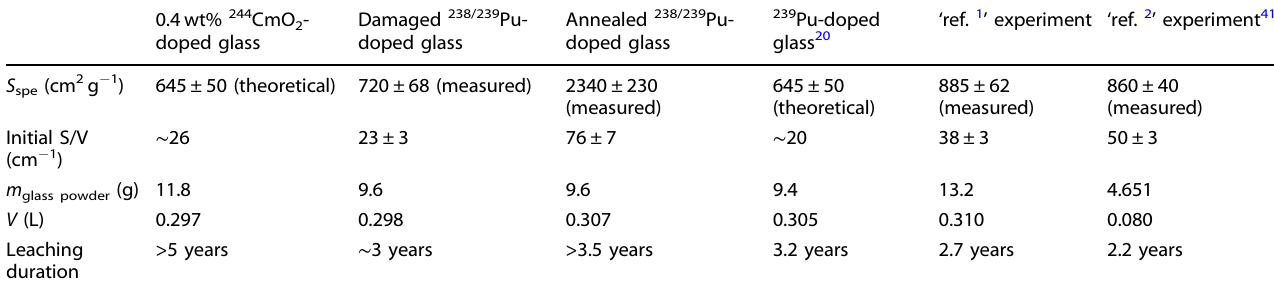
Table 4. Glass powder samples and leaching conditions